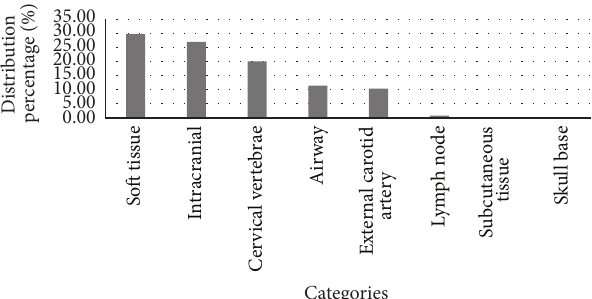
Figure 2: Distribution of findings.